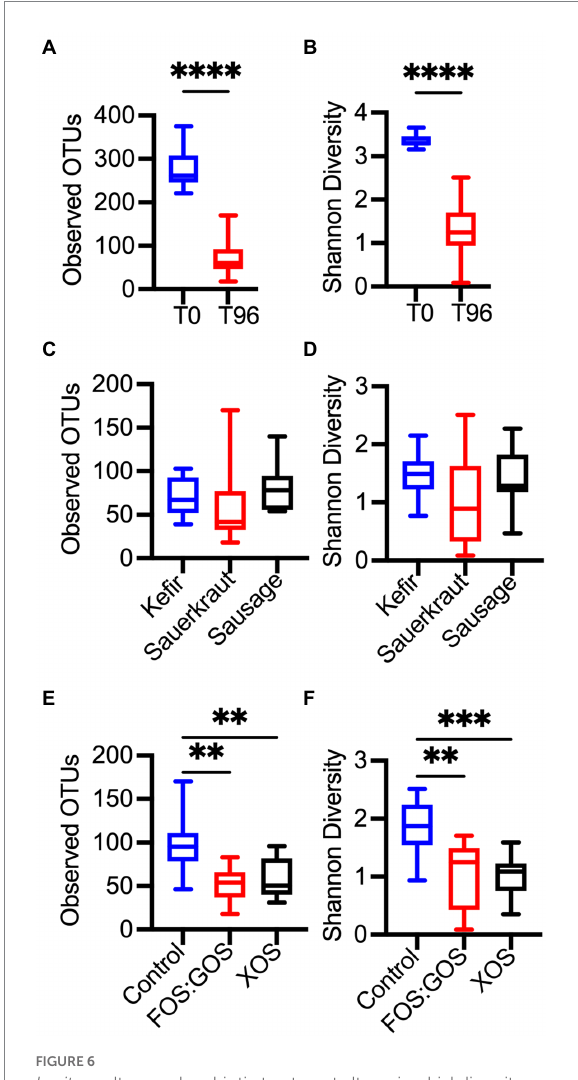
FIGURE 6 In vitro culture and prebiotic treatment alter microbial diversity. Differences in microbial diversity as a result of time in culture (A,B) , exposure to a fermented food (C,D) , or the presence or absence of prebiotics (E,F) was determined for the four fecal cultures described in Figures 1A–C, 2. Microbial richness was assessed through observed OTUs (A,C,E) and Shannon Diversity (B,D,F) . In (A,B) , microbial richness and diversity was compared between replicates collected at the start of in vitro culture (T0, n = 12) and following 96 h of culture (T96, n = 36). In (C,F) , microbial richness and diversity were compared between indicated treatments after 96 h of culture ( n = 12 samples/ treatment). Box plots indicate the 25th-75th percentile of values, a horizontal line indicates the median value, and vertical whiskers indicate the minimum and maximum values. All comparisons with p -values <0.05 are reported. ** p < 0.01, *** p < 0.005, **** p <